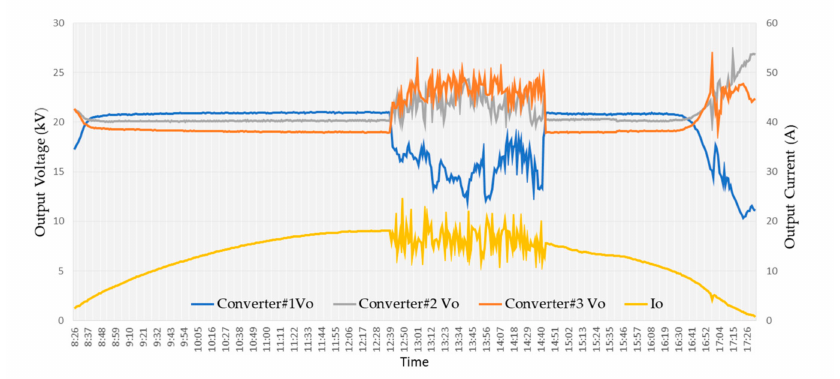
Figure 27. Converters waveform in rapid various irradiance